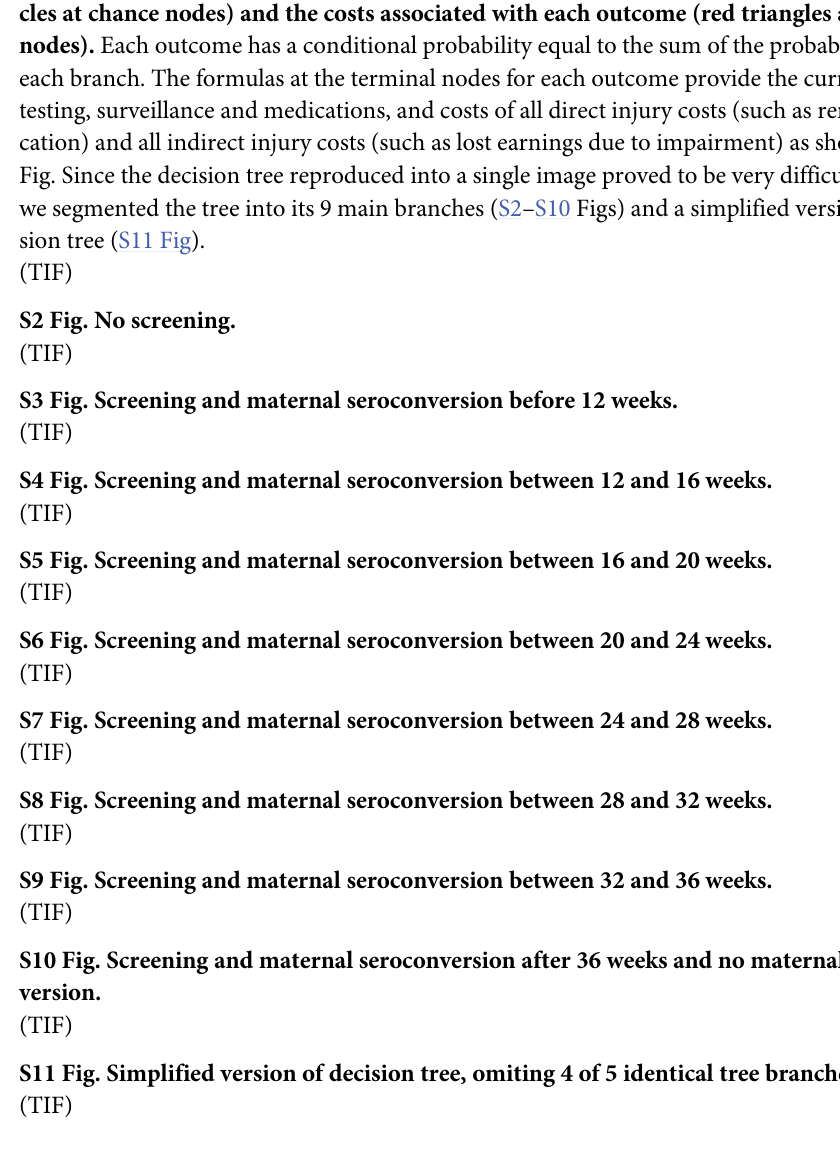
S3 Fig. Screening and maternal seroconversion before 12 weeks. S4 Fig. Screening and maternal seroconversion between 12 and 16 weeks. S5 Fig. Screening and maternal seroconversion between 16 and 20 weeks. S6 Fig. Screening and maternal seroconversion between 20 and 24 weeks. S7 Fig. Screening and maternal seroconversion between 24 and 28 weeks. S8 Fig. Screening and maternal seroconversion between 28 and 32 weeks. S9 Fig. Screening and maternal seroconversion between 32 and 36 weeks. S10 Fig. Screening and maternal seroconversion after 36 weeks and no maternal serocon- version. S11 Fig. Simplified version of decision tree, omiting 4 of 5 identical tree